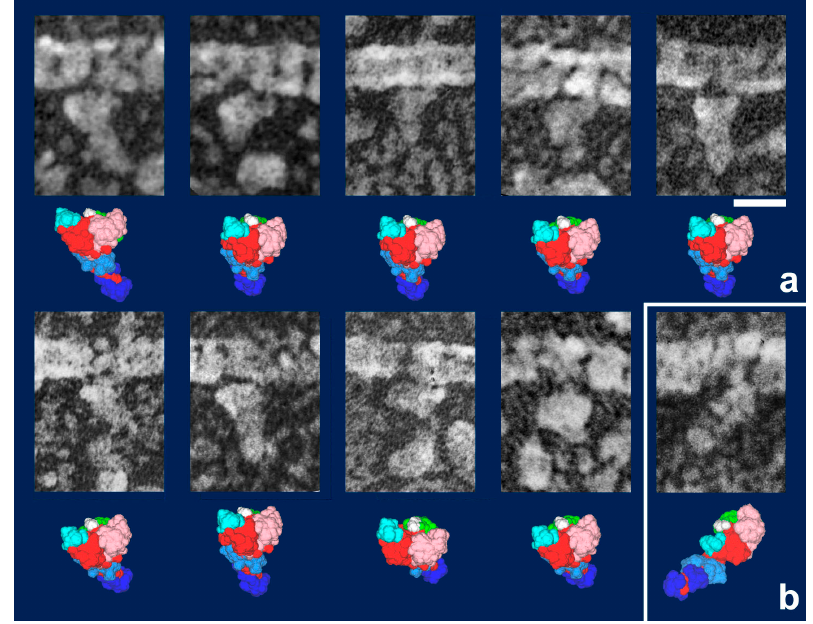
Figure 5. ( a ) Gallery of HMM heads attached to actin during sliding, but with different orientation from those in Figure 4a. Though the global configuration of the particles is the same as that of thiol-crosslinked one, the lever-arm portions are visible and the plane including upper and lower 50 KDa subdomains in these particles is oriented almost perpendicular to the main axis of actin-filament, similarly to that under rigor condition. Since actin contacts through two paired-sites are established in this orientation, simple extension of the lever-arm from this state might readily and smoothly lead to rigor-configuration (i.e., the power-stroke); ( b ) A particle in rigor configuration. (N.B.: Though the statistical analyses are still left as the matter for future study, tentative ratio of particles in “weakly-bound configuration” vs. “primed configuration” vs. “Vi configuration” among actin-bound myosin heads during sliding might be very roughly 6:3:1). Refer to [33] for further arguments. Scale bars exhibit 10 nm.